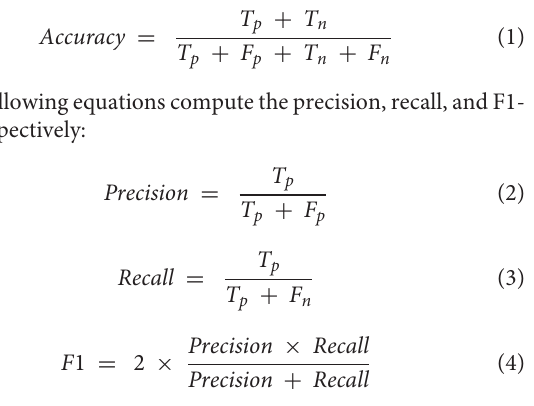
FOV: 94o. Multiple flights were used with an altitude between 5 and 6 m from the ground to capture the